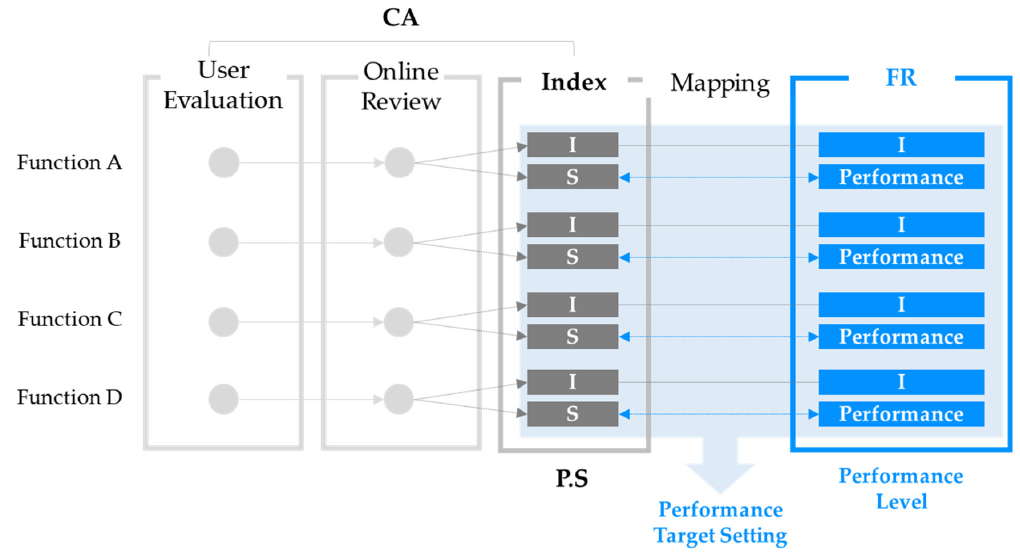
Figure 4. Relationship between satisfaction and performance in product development process.